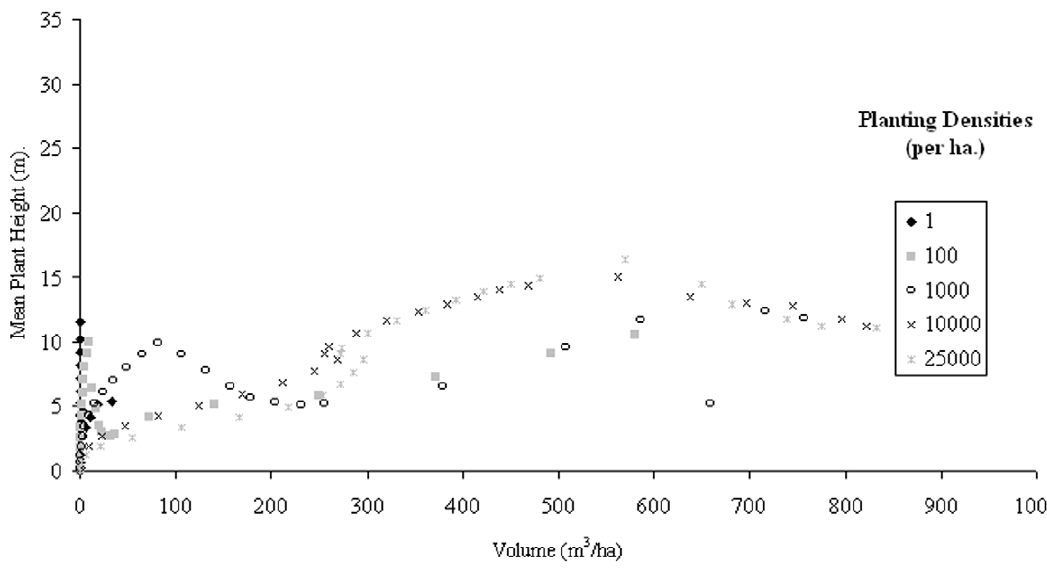
Figure 2. AbiesAlba H mean against stand volume over a period of 100 years.